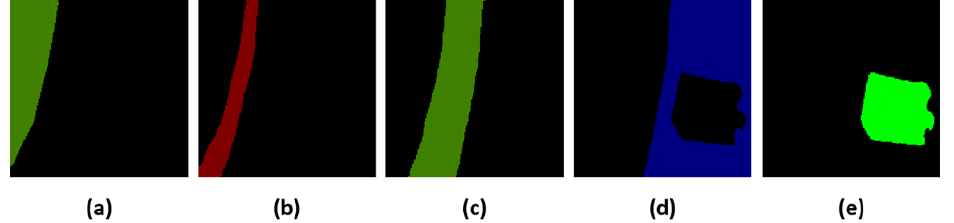
Figure 7. Small-scale objects. It shows the small-scale objects of the image. (a) is service_0 (in order to distinguish between different objects of the same class, we number each object); (b) is road_0; (c) is service_1; (d) is green_space _0; and (e) is residence_0.